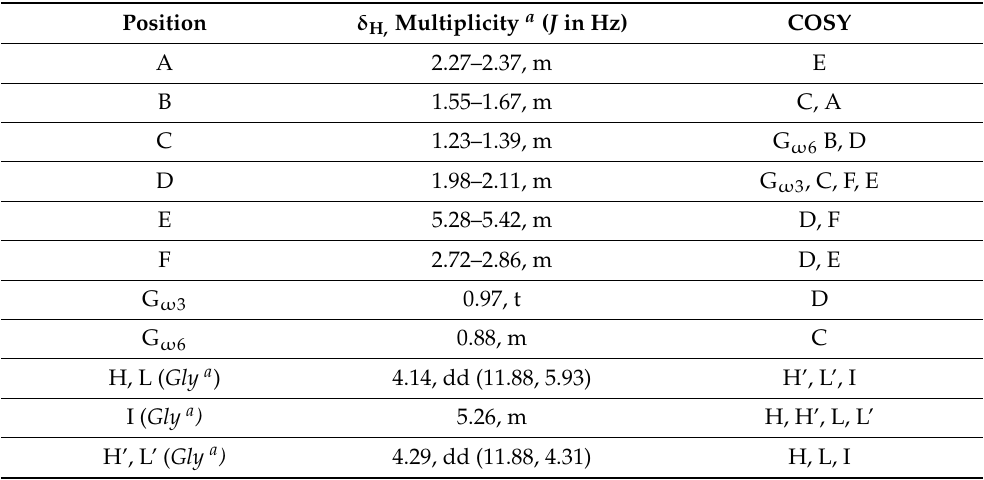
Table 1. 1 H NMR chemical shifts and 1 H/ 1 H correlations of fatty acid protons in triacylglicerols (TAGs) in CDCl 3 for hemp seed extracts.